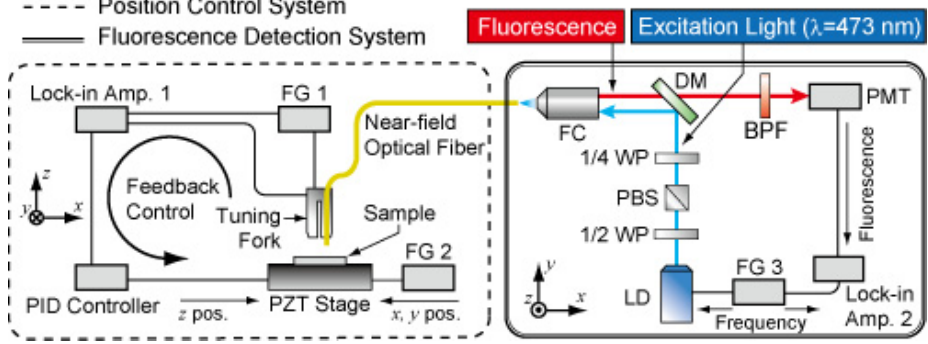
Figure 3. Experimental apparatus of Fluor-NOTN. WP, wavelength pass; PBS, polarized beam splitter; DM, dichroic mirror; FC, fiber coupler; PMT, photomultiplier tube; FG, function